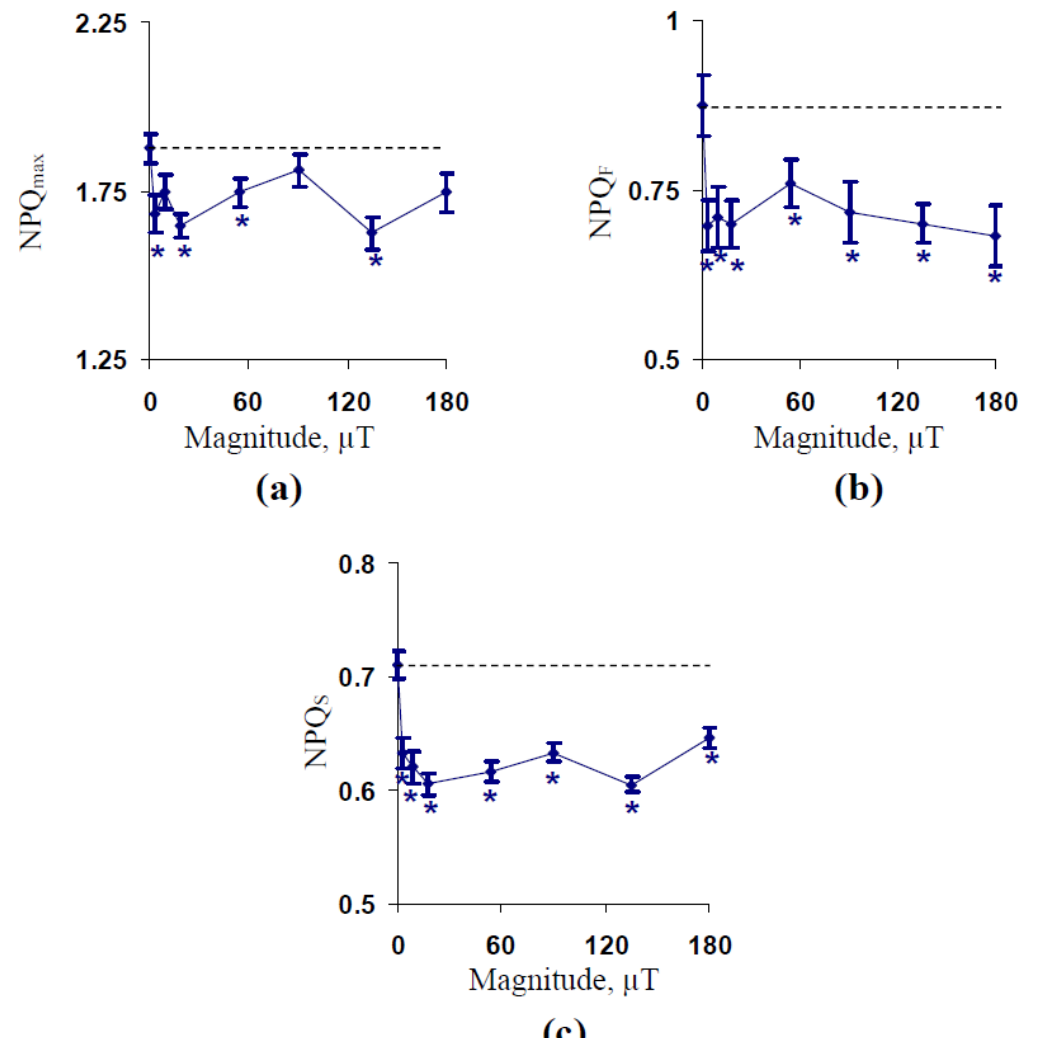
Figure 2. Dependencies of maximal value of non-photochemical quenching (NPQ max ) ( a ), a fast-relaxing component of the non-photochemical quenching under illumination (NPQ F ) ( b ), and a slow-relaxing component of the non-photochemical quenching after this illumination (NPQ S ) ( c ) on the magnitude of ELFMF with the 14.3 Hz frequency in wheat seedlings ( n = 20 – 30). The action of the artificial ELFMF was initiated before the dark adaptation; the 30 min treatment was used. Photosynthetic parameters were measured under the treatment. Control seedlings were not treated by ELFMF (dotted line marked the photosynthetic parameters in these seedlings). *, the difference between photosynthetic parameters in the experimental and control wheat seedlings was significant ( p <